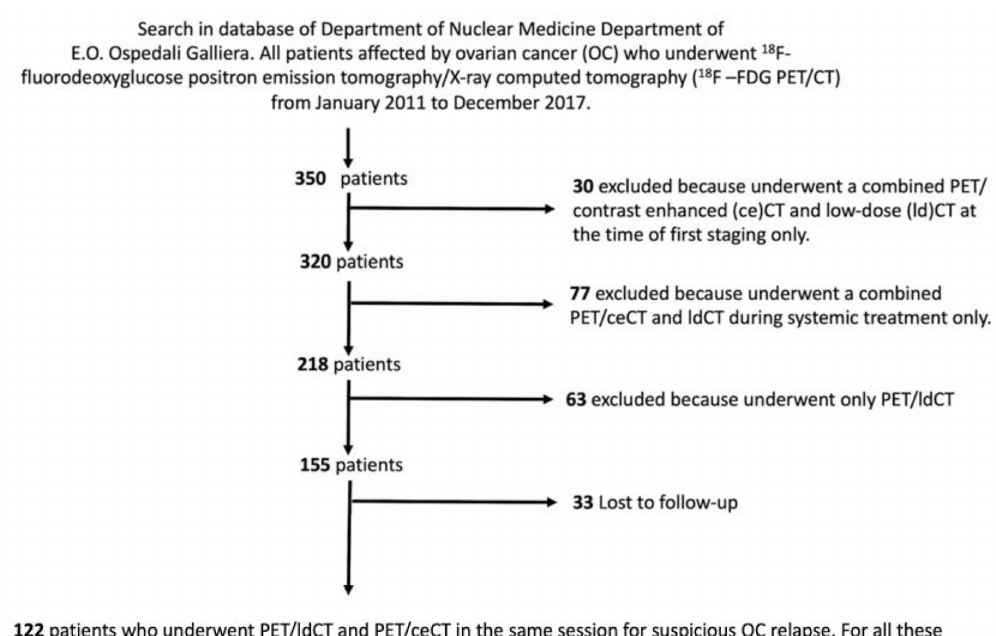
Figure 1. Process of patients’ selection. The flowchart details the initial size of the population sample ( top ), the number of excluded patients with relative reasons ( right ), and the final sample ( bottom